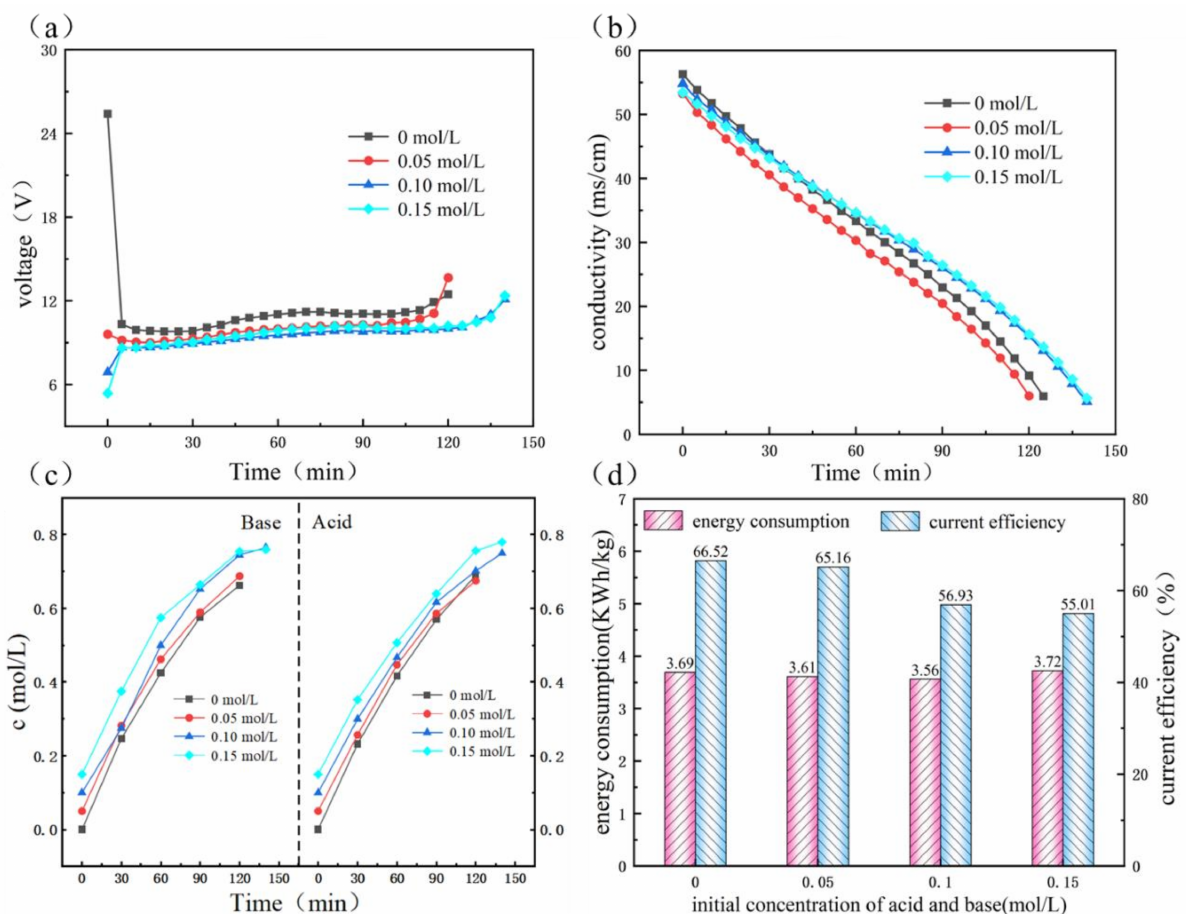
Figure 8. Effect of the initial HCl and NaOH contents on ( a ) membrane stack voltage; ( b ) conductivity of feed compartment; ( c ) the concentrations of acid and base; ( d ) current efficiency and energy consumption. The feed conductivity: 55 mS/cm; current density: 20 mA/cm 2 ; flow velocity: 20